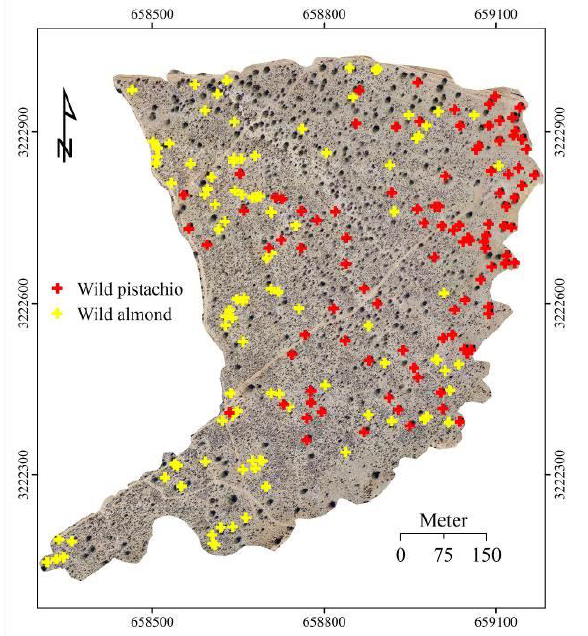
Figure 5. The UAV orthoimagery of the study area with spatial resolution of 3.5 cm (orthorectification RMSE = 8 cm). Red and